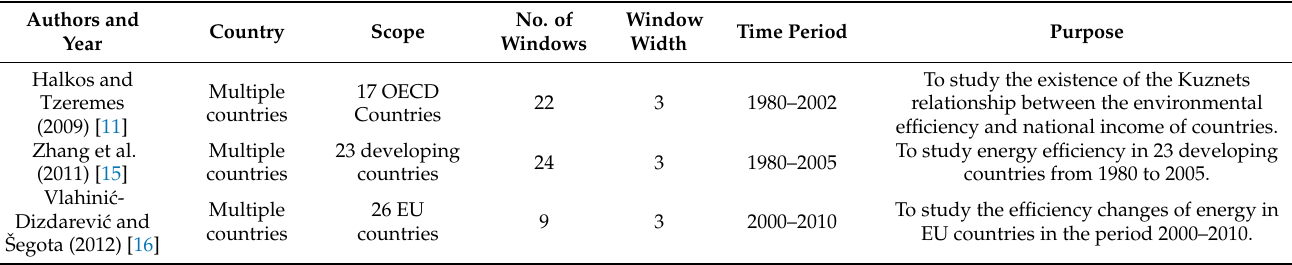
Table 3. Articles classified under the energy and environment